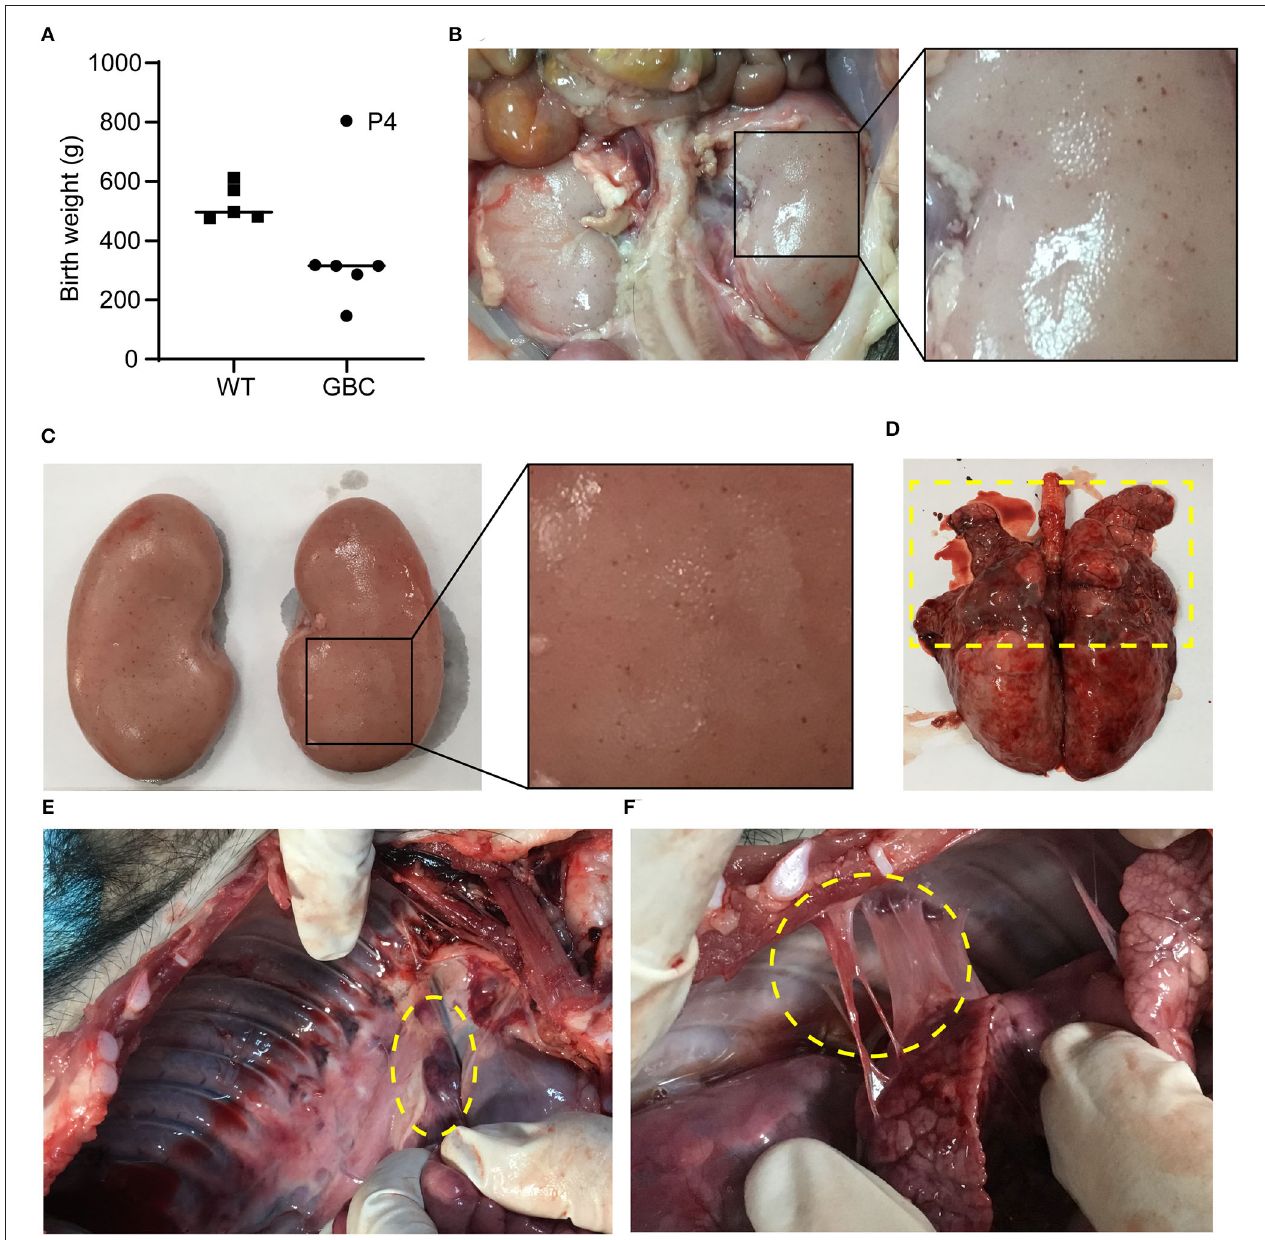
FIGURE 2 | Autopsy of GBC-modified pigs. (A) Birth weight of GBC-modified piglets. (B,C) A lot of spot bleeding in the kidney of GBC-modified pig P4P2 (13 days). (D) The lungs of GBC-modified pig P4P1 (93 days), indicating severe suppuration and necrosis in the upper part. (E) Enlarged peripulmonary lymph nodes in pig P4P1. (F) Adhesion between the lungs and the chest wall in pig P4P1.